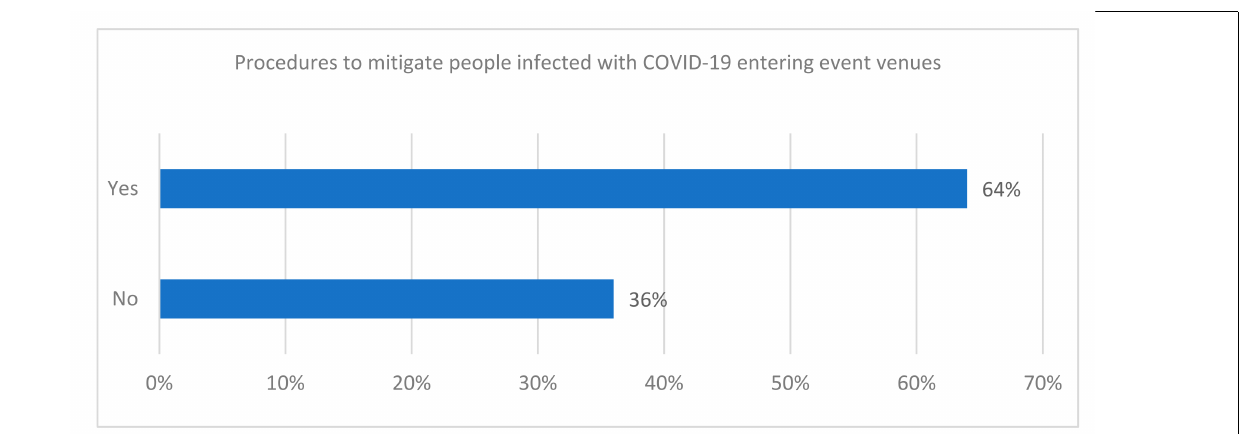
Figure 3. Procedures to mitigate people infected with COVID-19 entering event venues ( n = 14).